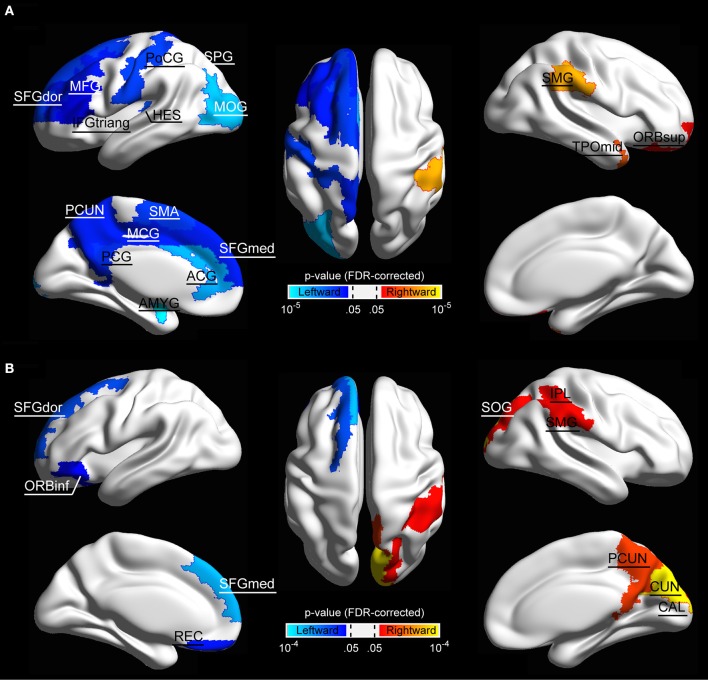
The surface distribution of cortical regions showing significant hemisphere effect in (A) structural network and (B) functional network. Color bar indicates p-values, and the threshold value for establishing significance was set p < 0.05 (FDR-corrected). Significant regions were overlaid on inflated surface maps with BrainNet Viewer software (Xia et al., 2013). For the abbreviations of the cortical regions, see Table 2.